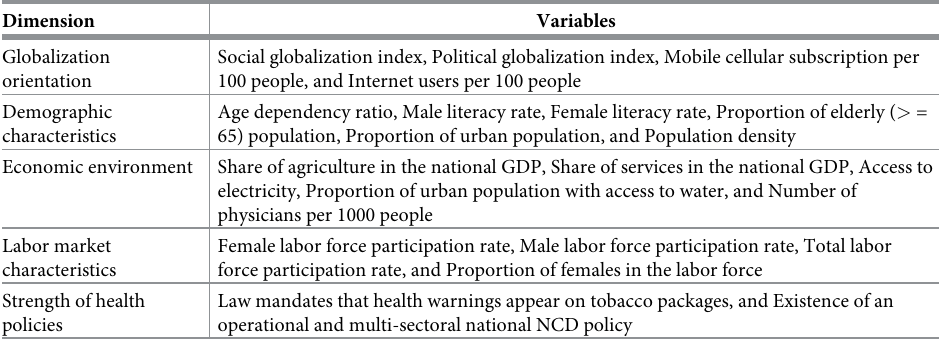
Table 1. Macro-environmental dimensions and respective